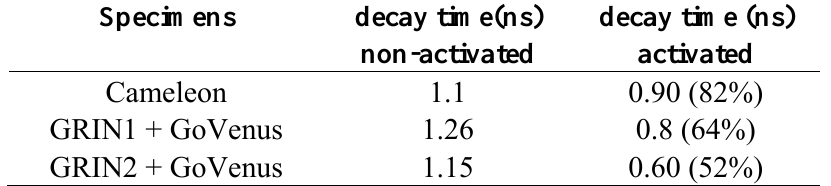
Table 2. Decay time shortening of donor protein (CFP) by FRET mechanism.